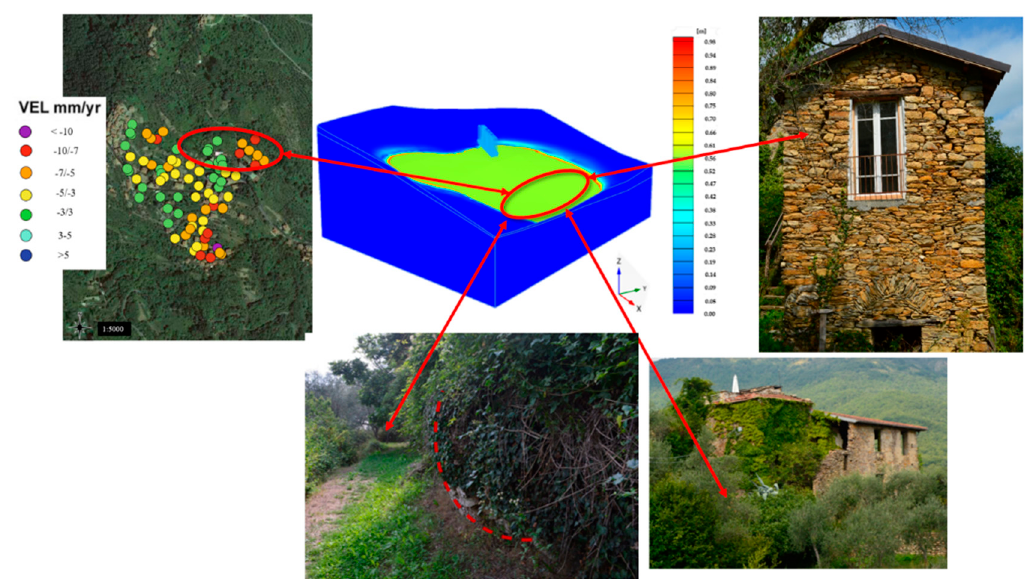
Figure 20. Model validation referred to the lower part of Ville San Pietro.